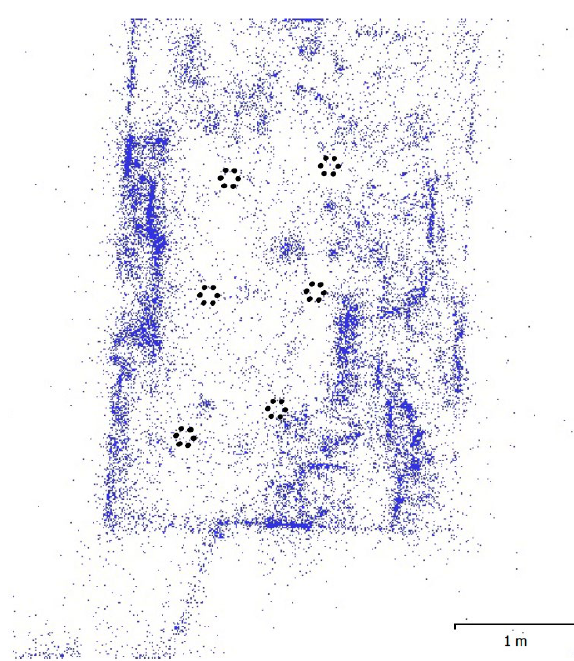
Figure 5. Point cloud in vertical view with camera locations.